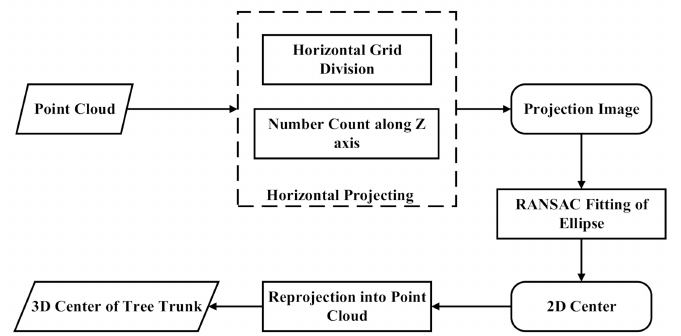
Figure 3. Precise localization of tree trunk